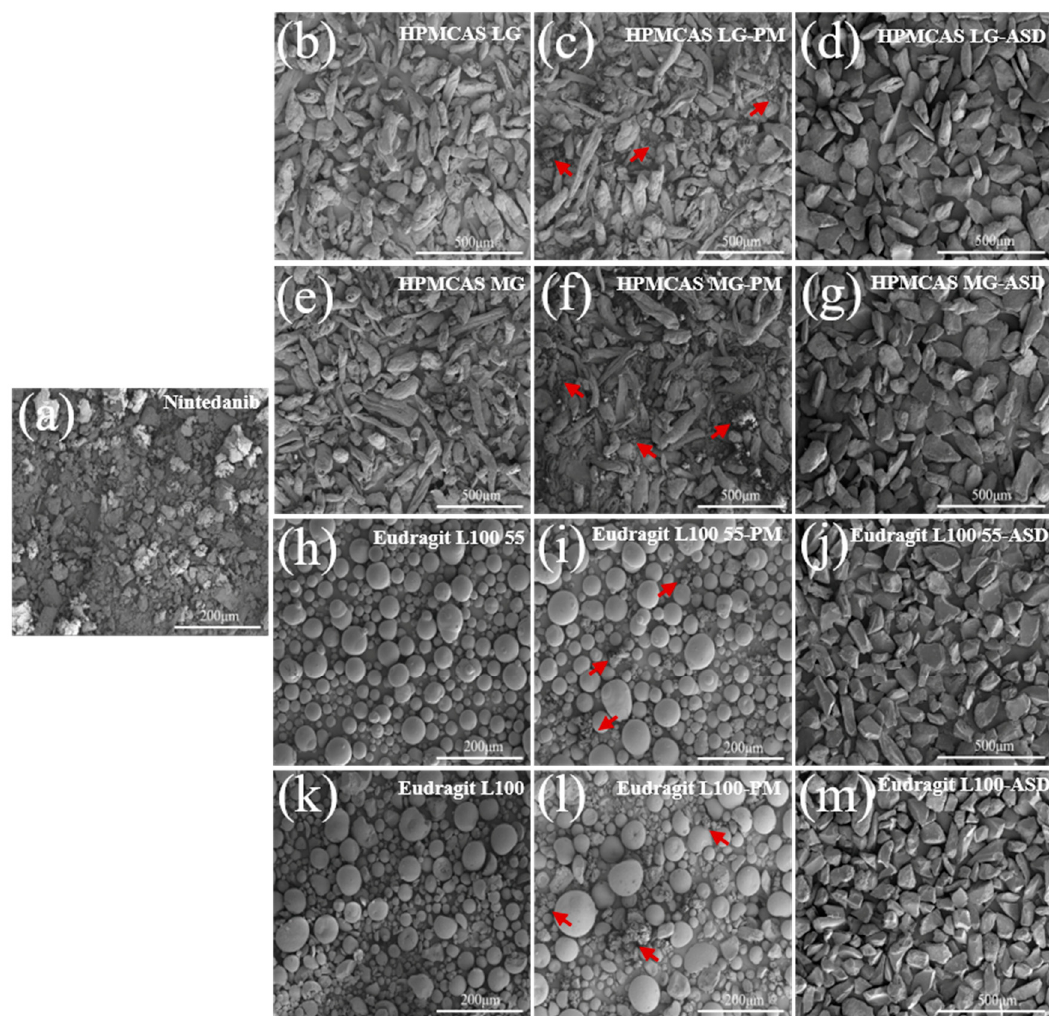
Figure 6. SEM images of ( a ) nintedanib, ( b ) HPMCAS LG, ( c ) HPMCAS LG–PM, ( d ) HPMCAS LG– ASD, ( e ) HPMCAS MG, ( f ) HPMCAS MG–PM, ( g ) HPMCAS MG–ASD, ( h ) Eudragit L100 55, ( i ) Eudragit L100 55–PM, ( j ) Eudragit L100 55–ASD, ( k ) Eudragit L100, ( l ) Eudragit L100–PM, ( m ) Eu- dragit L100–ASD. Arrows indicate drug crystal